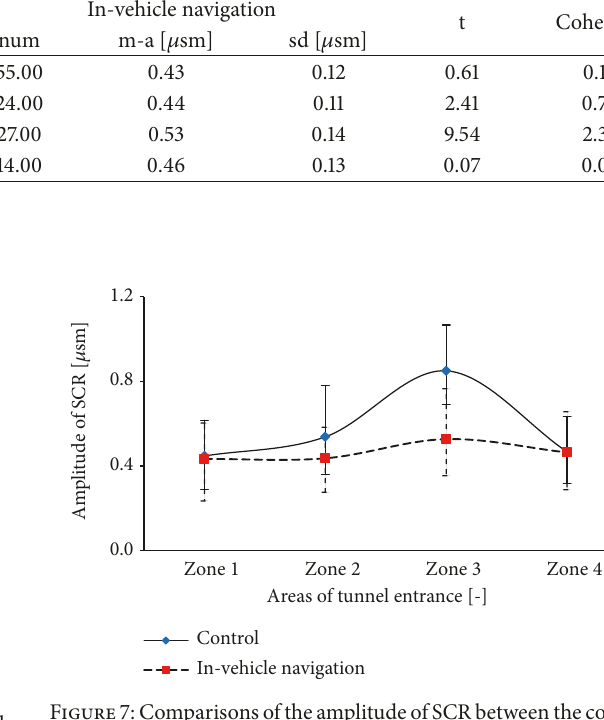
Figure 6: Comparisons of SCR between the control condition and in-vehicle navigation condition.